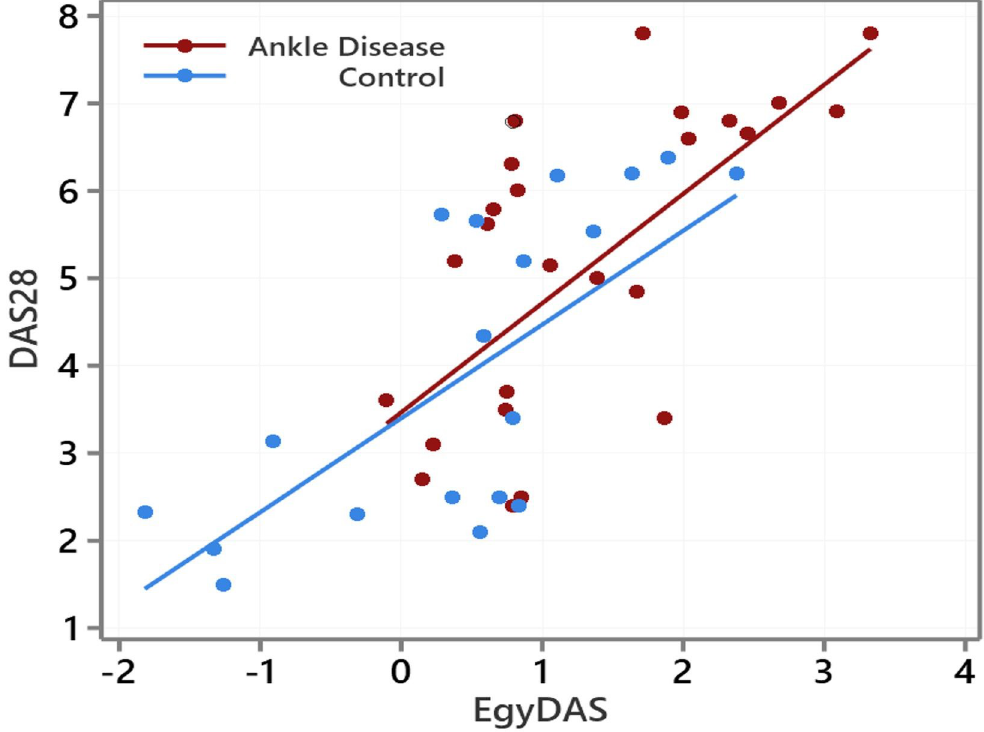
Fig 3. Scatter plot of EgyDAS and DAS28 scores for the two groups: Control and ankle involvement group along with the regression line. Red is for angle involvement group and blue if for the control group.